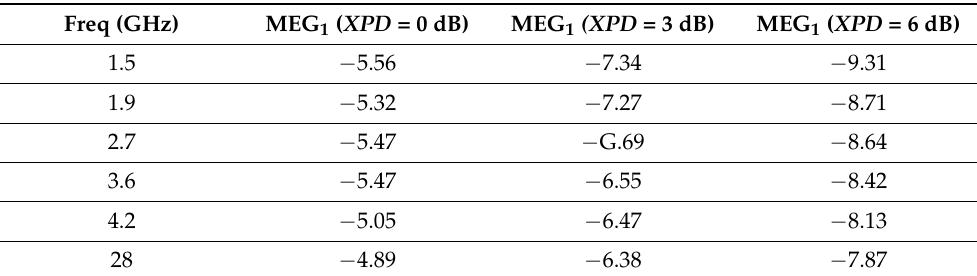
Table 3. MEG of proposed MIMO antenna.